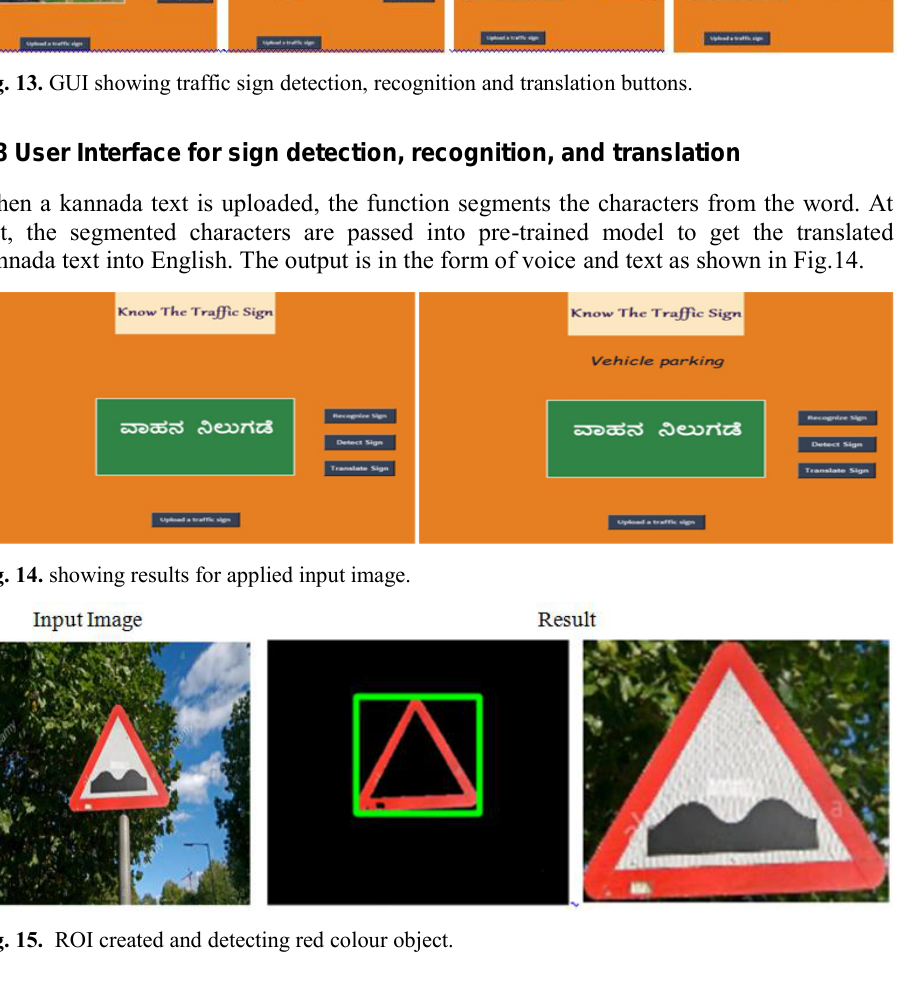
Accuracy and loss obtained from coloured images as shown in Fig. 16 & Loss